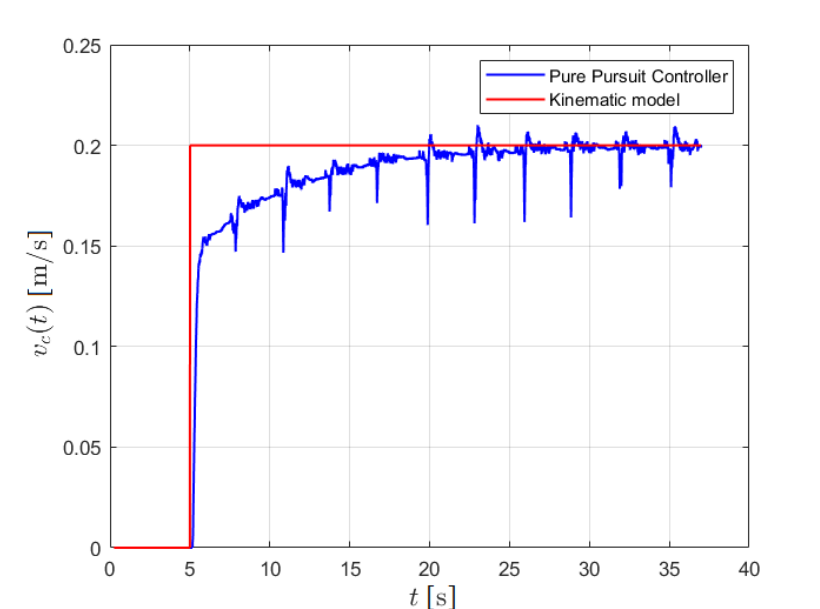
Figure 13. Linear velocity v c ( t ) of the robot.